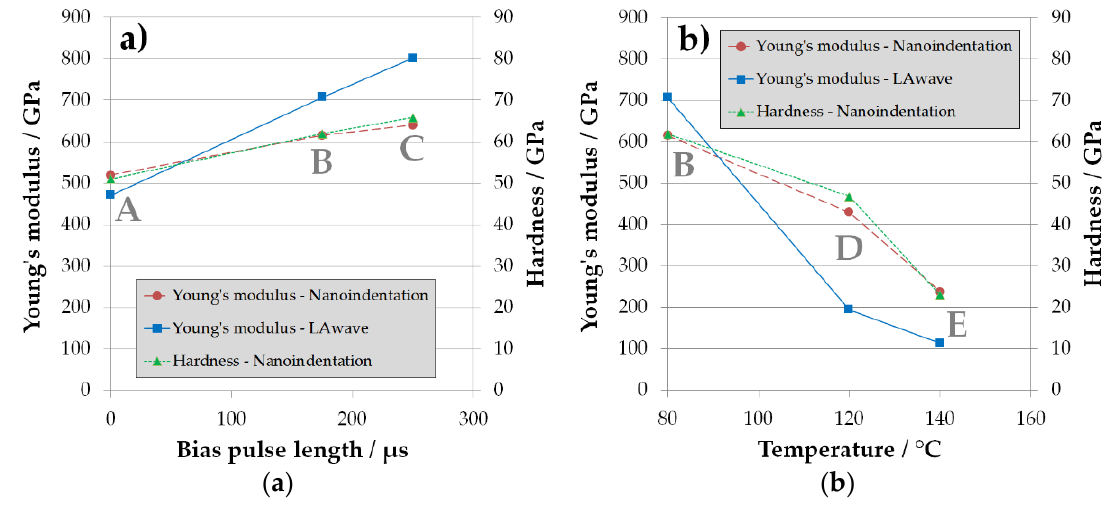
Figure 4. Dependence of the Young’s modulus (measured using two different techniques, nanoindentation and LAwave) and hardness on bias pulse length at 100 V, series A/B/C ( a ), and temperature, series B/D/E ( b ).